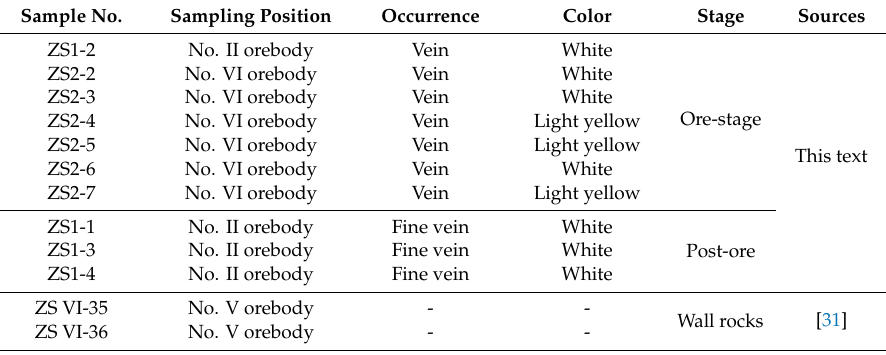
Table 1. Sampling locations and characteristics of calcite samples from the Zhesang gold deposit. Sample